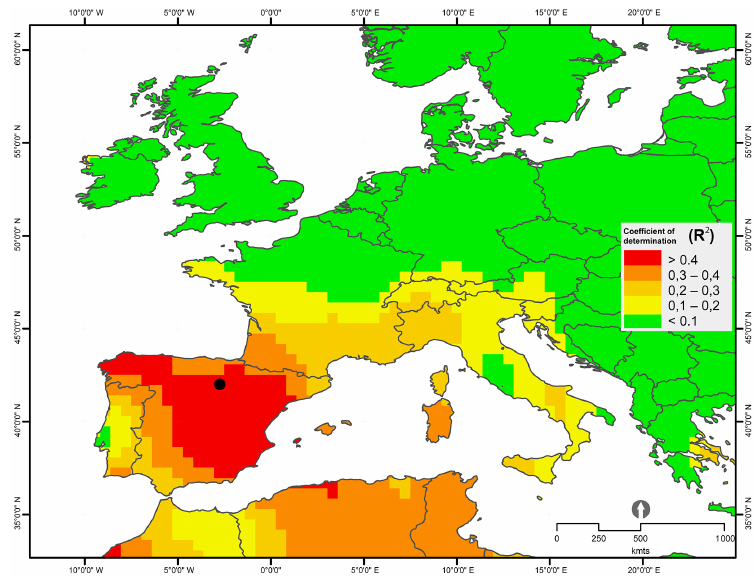
Figure 11. Map showing the spatial correlation patterns of the BasPois chronology with the gridded T max _21_Sep − 1 . Correlation values are significant at p < 0 .